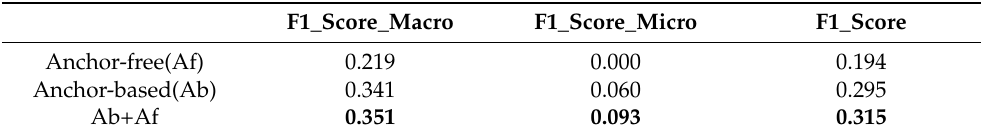
Table 2. Different spotting methods used for micro-expression spotting.